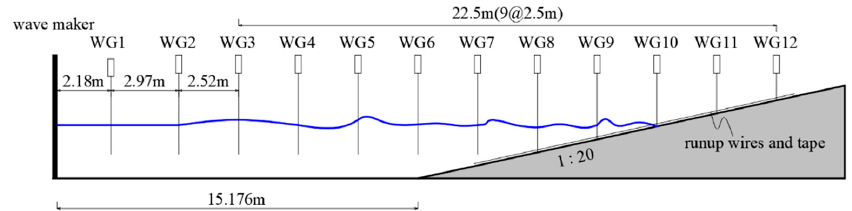
J. Mar. Sci. Eng. 2023 , 11 , 8 Figure 1. Experimental layout for the runup of focused wave group. Figure 1. Experimental layout for the runup of focused wave group.